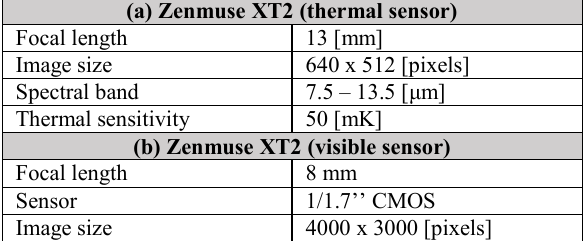
Table 1 . Main specifications of the DJI Zenmuse XT2